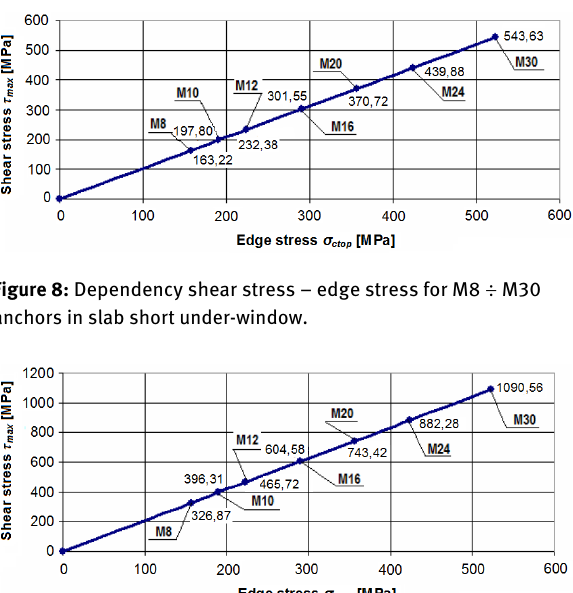
Figure 9: Dependency shear stress – edge stress for M8 ÷ M30 anchors in slab long under-window.